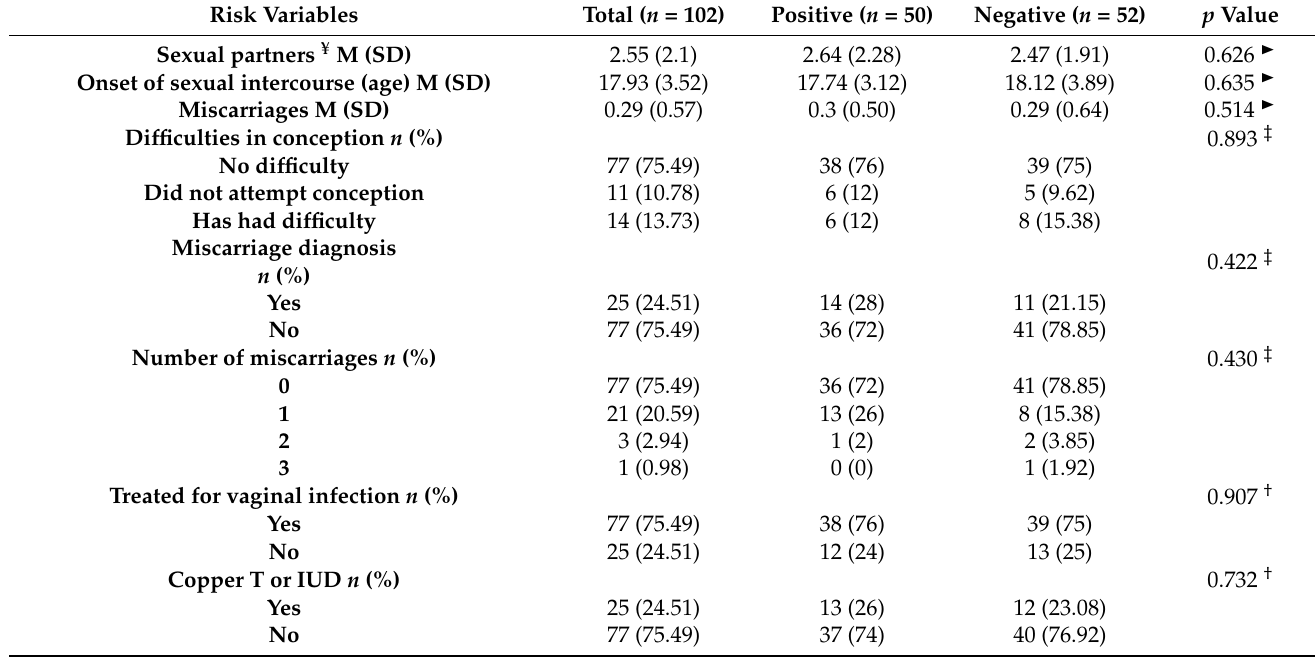
Table 2. Association of risk variables with positive or negative C. trachomatis , N. gonorrhoeae , and U. urealyticum results.